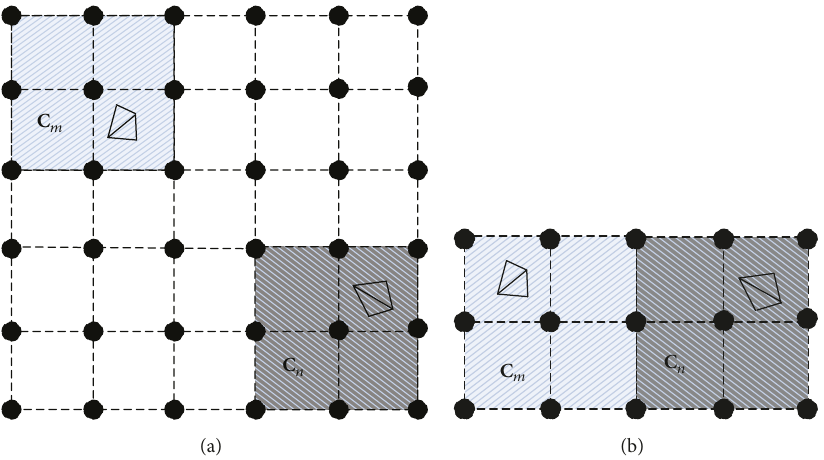
Figure 2: A 2D representation of the difference between the far elements and the near elements. (a) A far element without coincident point; (b) a near element with coincident points.